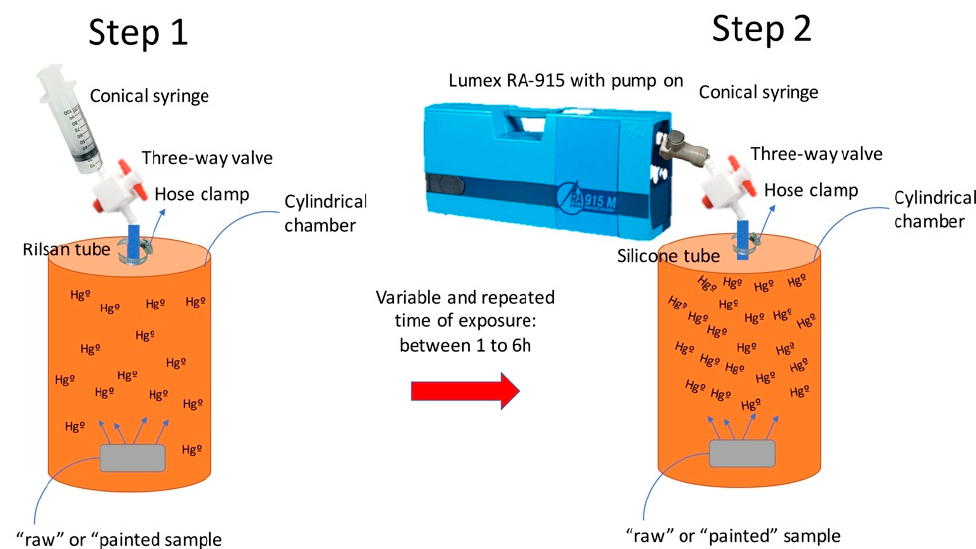
Figure 5. Schematic representation of the adopted procedure to measure the amount of Hg 0 released by geological and synthetic materials. The measurements were carried out into two steps. The first one uses a syringe and a three-way valve to mix the air into the cylindrical chamber to avoid stratification whilst in the second step the syringe is replaced by a connector that directly links to the Lumex RA-915M. The hose clamp is loosened and the three-way valve is turned to connect the air inside the cylindrical chamber to the Lumex to measure the emitted Hg 0 .